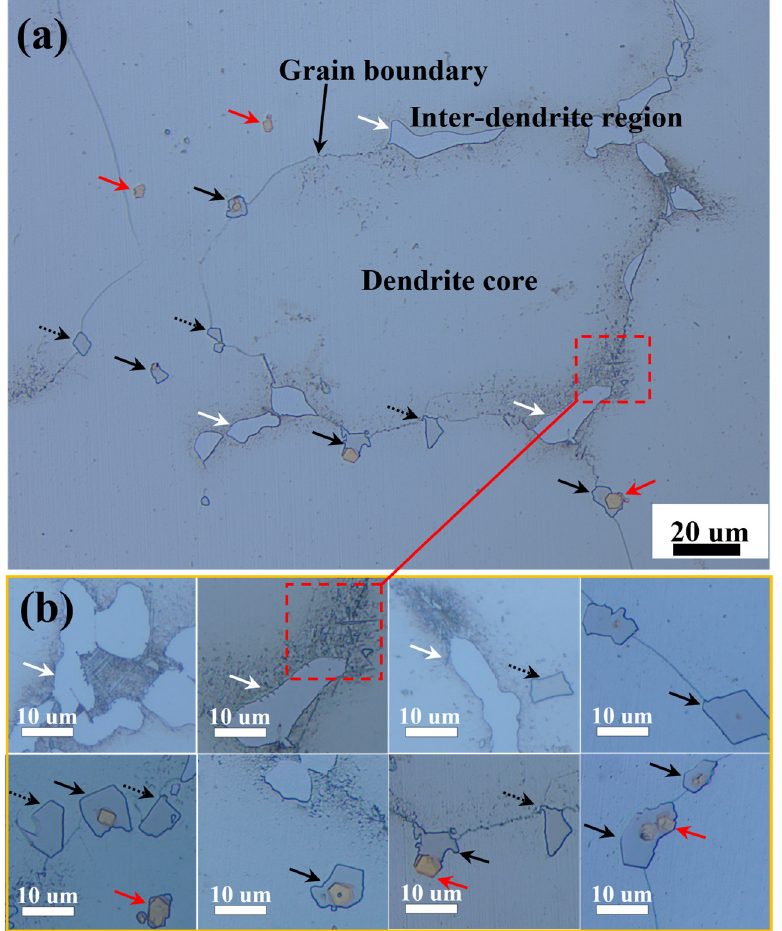
Figure 2. Microstructure of the second phases at R/2 of as-cast GH4169 with etchant 1 by OM, ( a ) R/2 500×, ( b ) partially enlarged pictures of second phases (red arrow pointing to orange inclusion, the black arrow pointing to MC, the white arrow pointing to Laves phase).